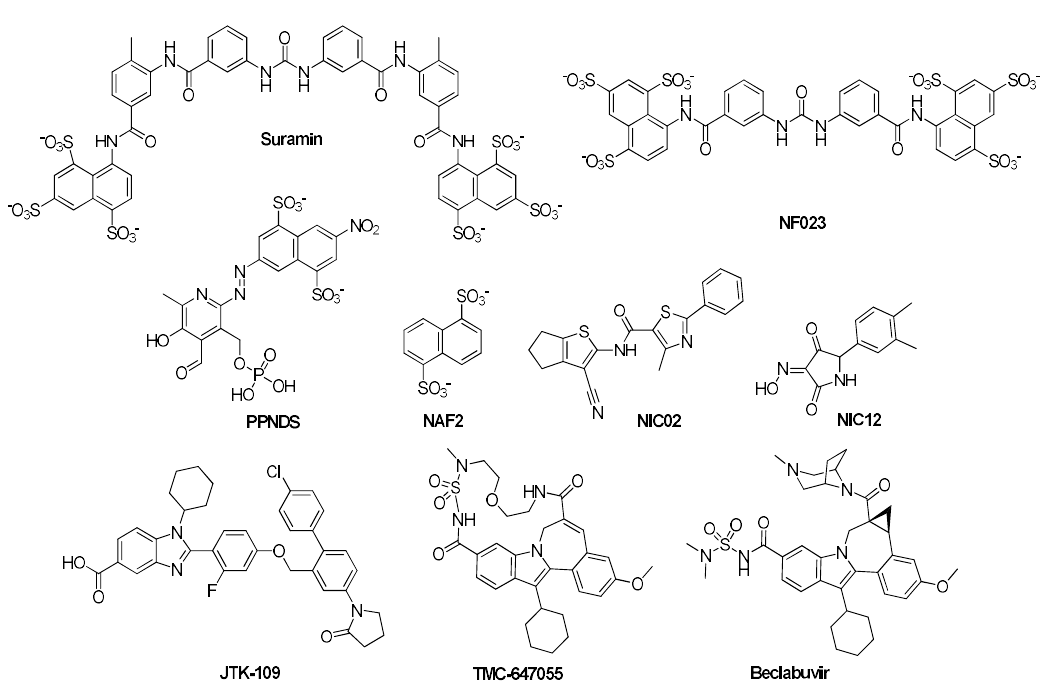
Figure 9. Predicted binding of one suggested potential broad-spectrum polymerase inhibitor to the